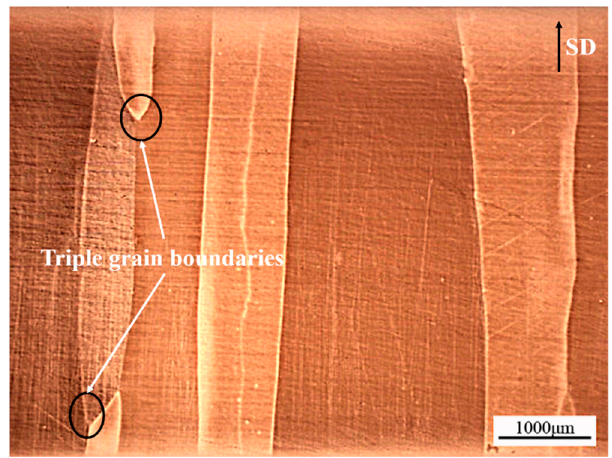
Figure 2. The optical microscopy graph of Cu 71.7 Al 18.1 Mn 10.2 alloy sample prepared by directional solidification. SD: Solidification direction.